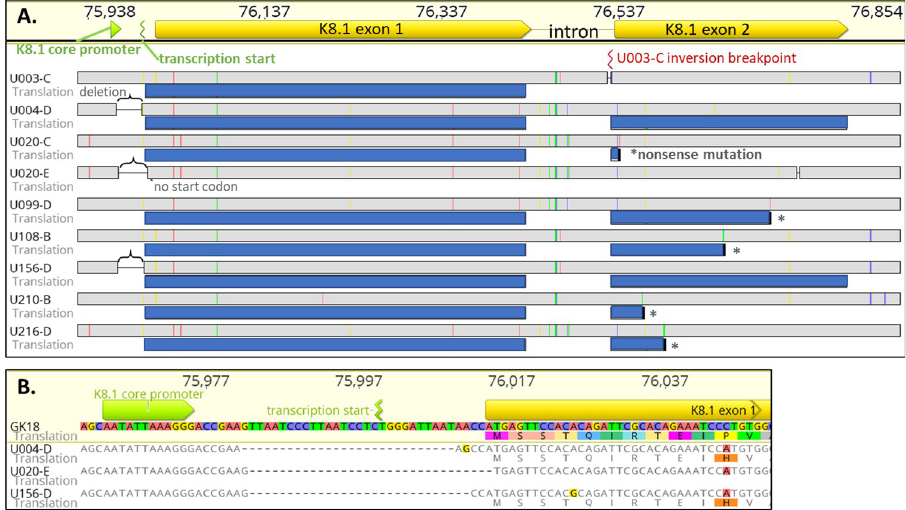
Fig 5. Inactivating mutations observed in the K8.1 gene. (A.) Highlighter plot of an alignment of K8.1 gene and promoter mutations found in this study, showing identical mutations from the same person once. Indicated above are locations of the K8.1 core promoter, transcription start site and open reading frame. Sequence coordinates are for reference isolate GK18. Gray bars in line with tumor IDs represent their nucleotide sequences, while blue bars below represent translations of open reading frames to their fullest extent. Colored ticks represent nucleotide differences from the GK18 sequence (red: A, blue: C, yellow: G, green: T), brackets indicate transcription start site deletions, asterisks indicate nonsense mutations, and red mark corresponds to the inversion breakpoint location in U003 tumors. (B.) Sequence alignment of the transcription start site deletions. Indicated below nucleotides are amino acid translations if there are open reading frames. Highlighted bases and amino acids correspond to those differing from the